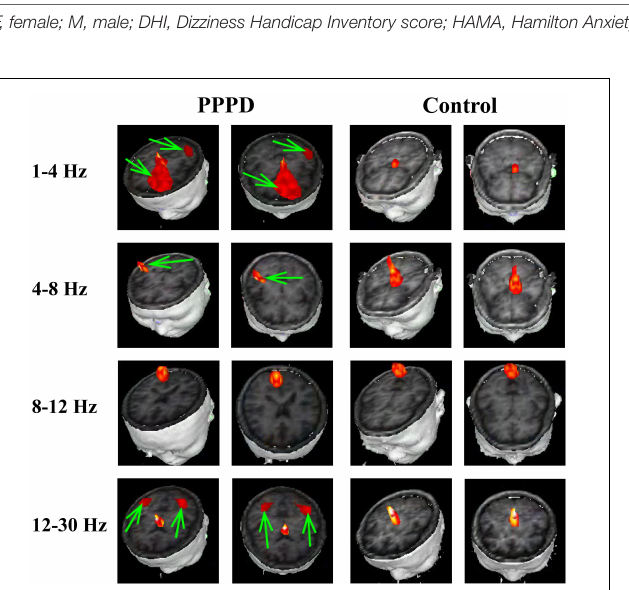
in low frequency band and clinical scores in PPPD patients.